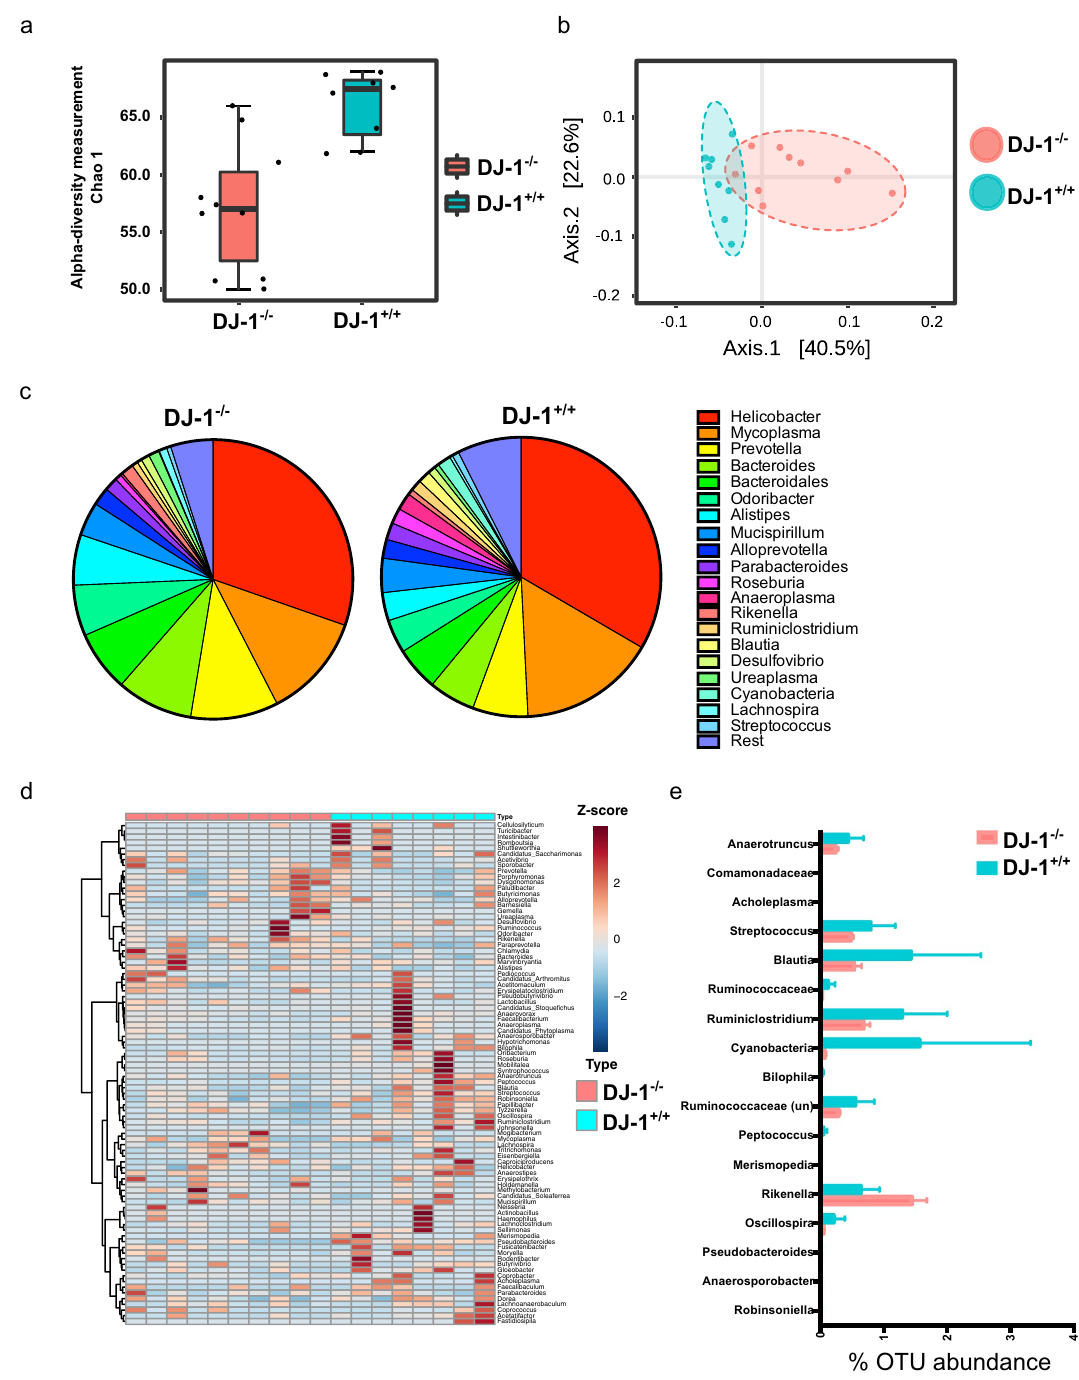
Figure 2. Increase in Rikenella and Alistipes bacteria in DJ-1 −/− mice compared with DJ-1 +/+ at four months of age. (a) Measurement of alpha (Chao1) diversity in DJ-1 +/+ and DJ-1 −/− mice. (b) Beta diversity (UniFrac) for WT (n = 8) and DJ-1 −/− (n = 10) mice. Both DJ-1 +/+ and DJ-1 −/− mice clusters in a separate group. (c) A representative image of abundance of bacteria at genus levels in all DJ-1 +/+ (n = 8) and DJ-1 −/− (n = 10) mice fecal samples. (d) Heat map represents the bacterial abundance in DJ-1 +/+ and DJ-1 −/− mice in all the animals. The abundance of bacteria at genera level are represented in Z-score. (e) Average statistically significant (p value of < 0.05) bacterial abundance at genus level (only significantly abundant genera are shown) using Student’s unpaired